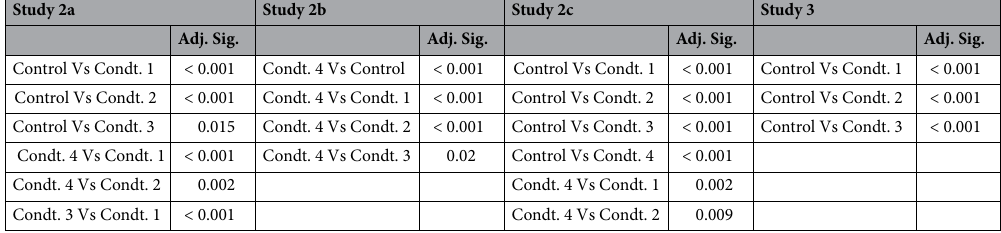
Table 2. Statistics with Bonferroni adjustments for the significant differences at pairwise level of studies 2 and 3.